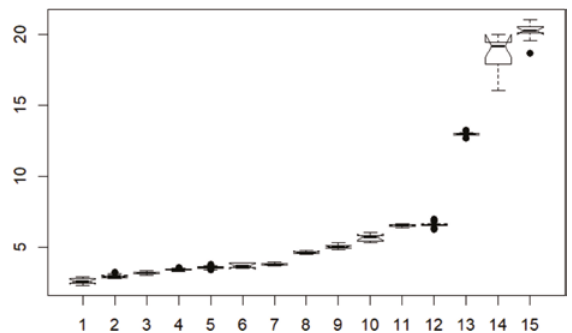
Fig. 5. Boxplots illustrating the continuous variability of GS (Genome Size), as inferred from de Kruskal Wallis analysis. The numbers on the x axis represent the species ordered by crescent C-values (in pg): S. flaccidum (1), S. pseudocapsicum (2), S. adsper- sum (3), S. scuticum (4), S. variabile (5), S. concinnum (6), S. sanctae- catharinae (7) S. inodorum (8) S. palinacanthum (9) S. acerifolium (10), A. arborescens (11) B. uniflora (12) P. pubescens (13) S. diplo- conos (14) C. laevigatum (15). The central box represents 50% of the data from de upper to lower quartile. The horizontal bar expresses the median position. The extremity of the vertical lines indicates minimum and maximum values of HKL, if they are no outliners. When outliners are present, they are represented by circles.